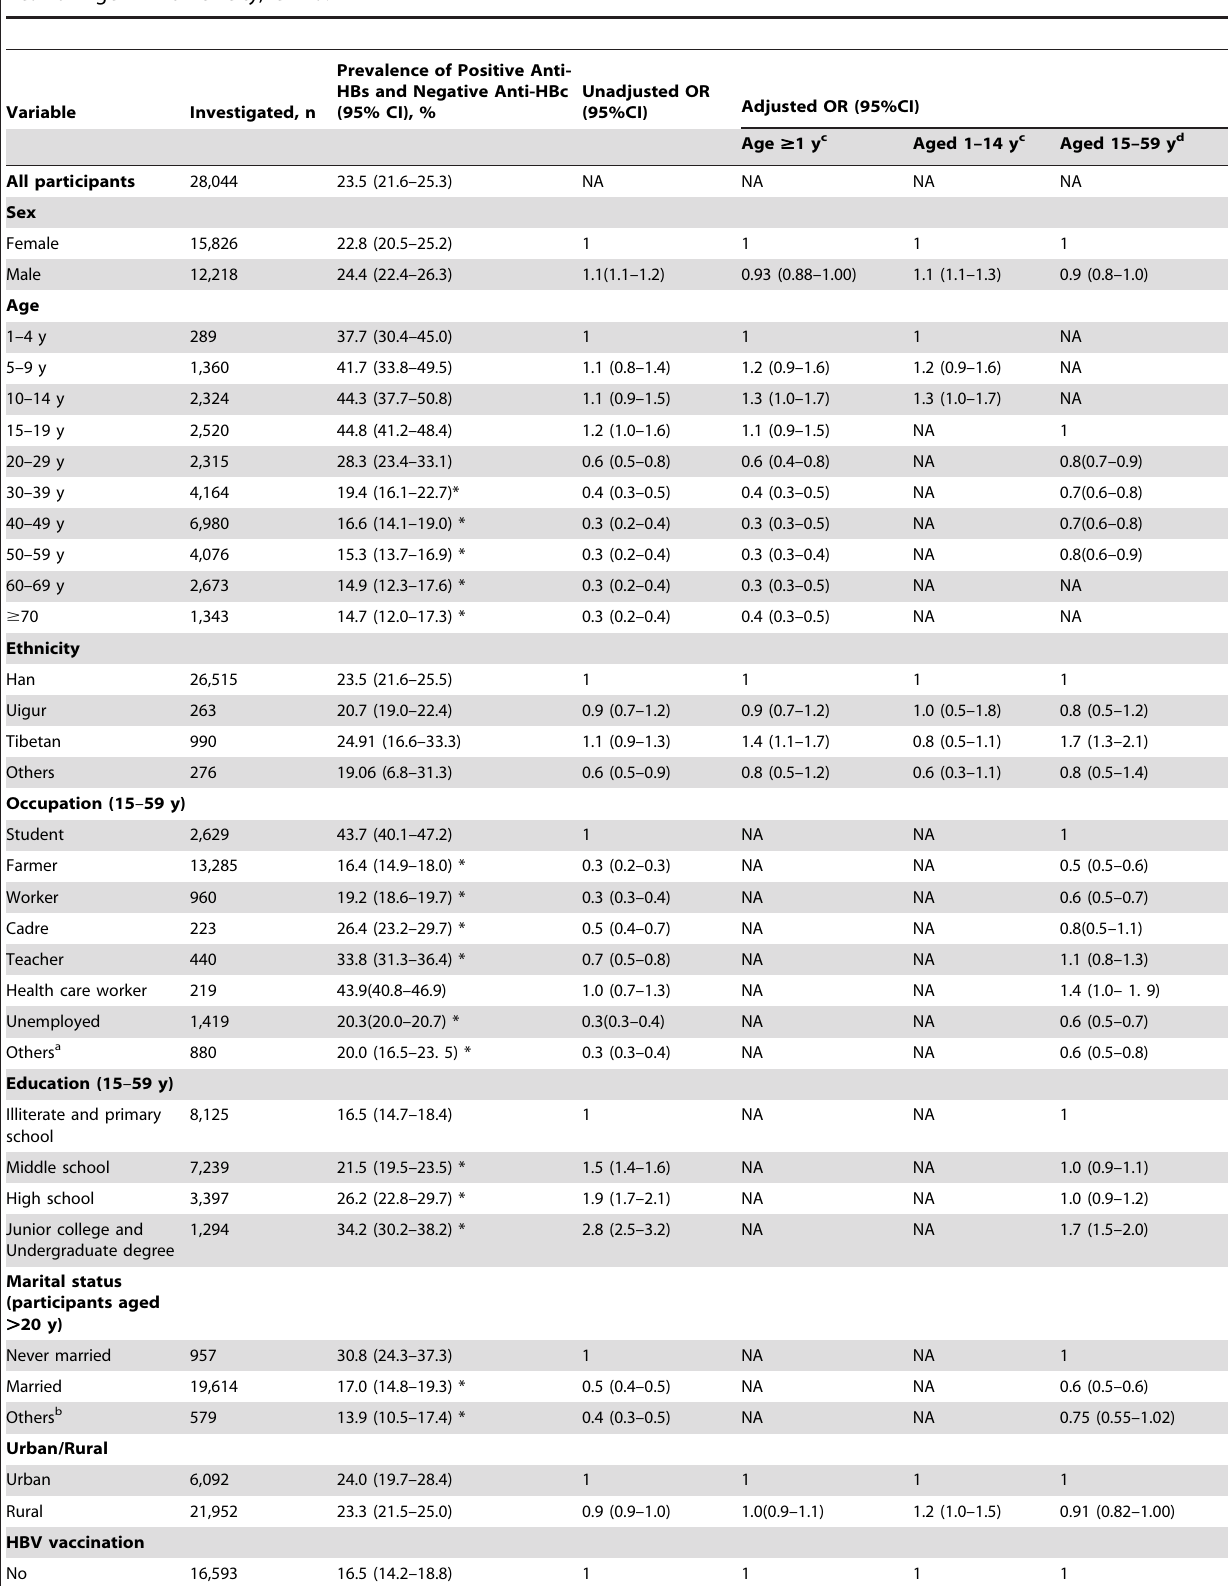
Table 3. Prevalence and Determinants Associated with the Presence of Anti-HBs and Without Anti-HBc Among Persons Aged $ 1 Year of Age in Wuwei City,